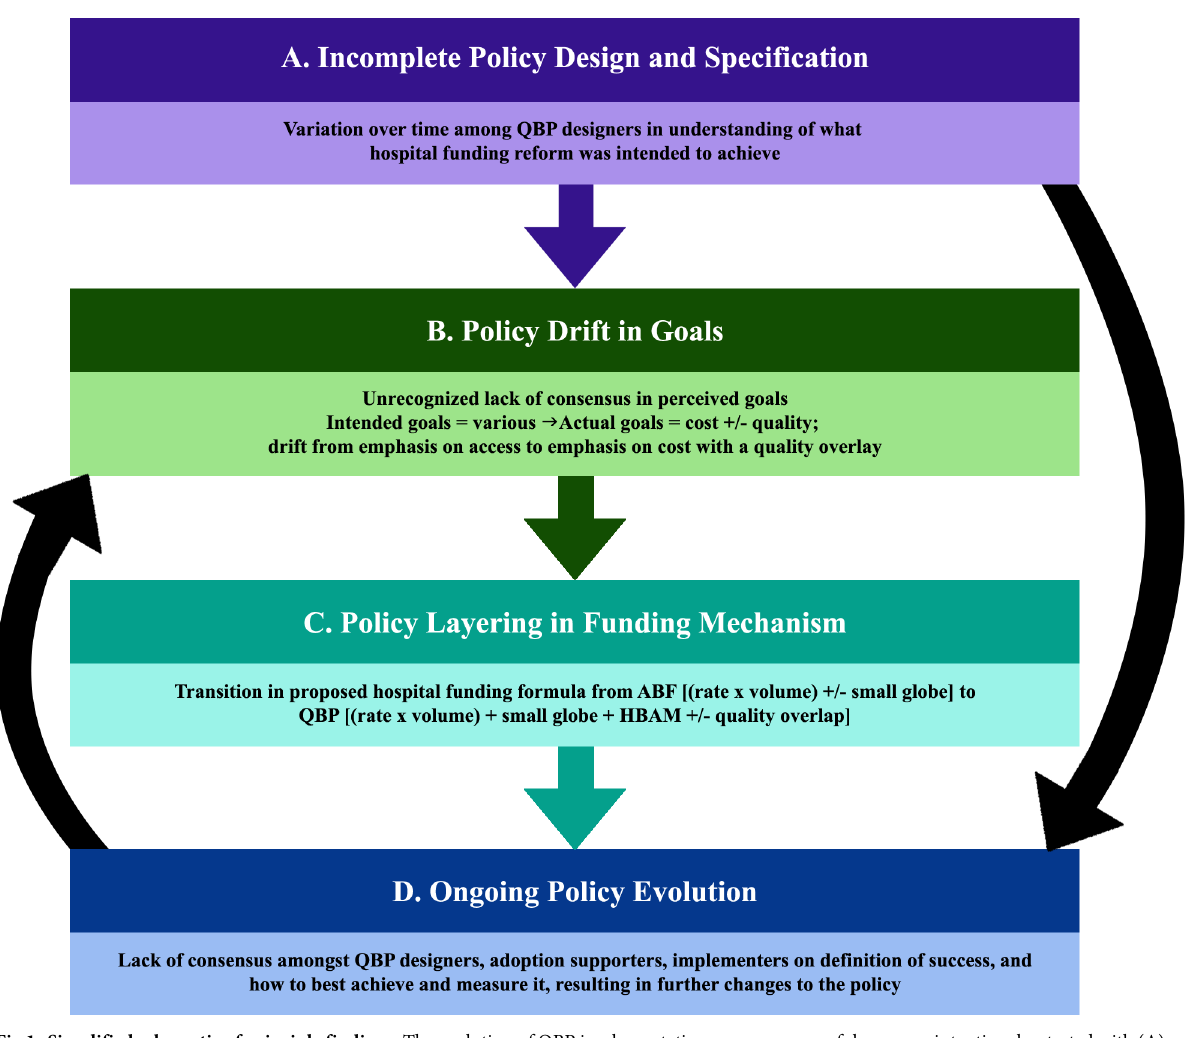
Fig 1. Simplified schematic of principle findings. The evolution of QBP implementation—some purposeful, some unintentional—started with (A) incomplete policy design, which (B) influenced the goals of the policy and (C) changed the funding reform mechanism, ultimately (D) altering the trajectory of the entire hospital funding reform